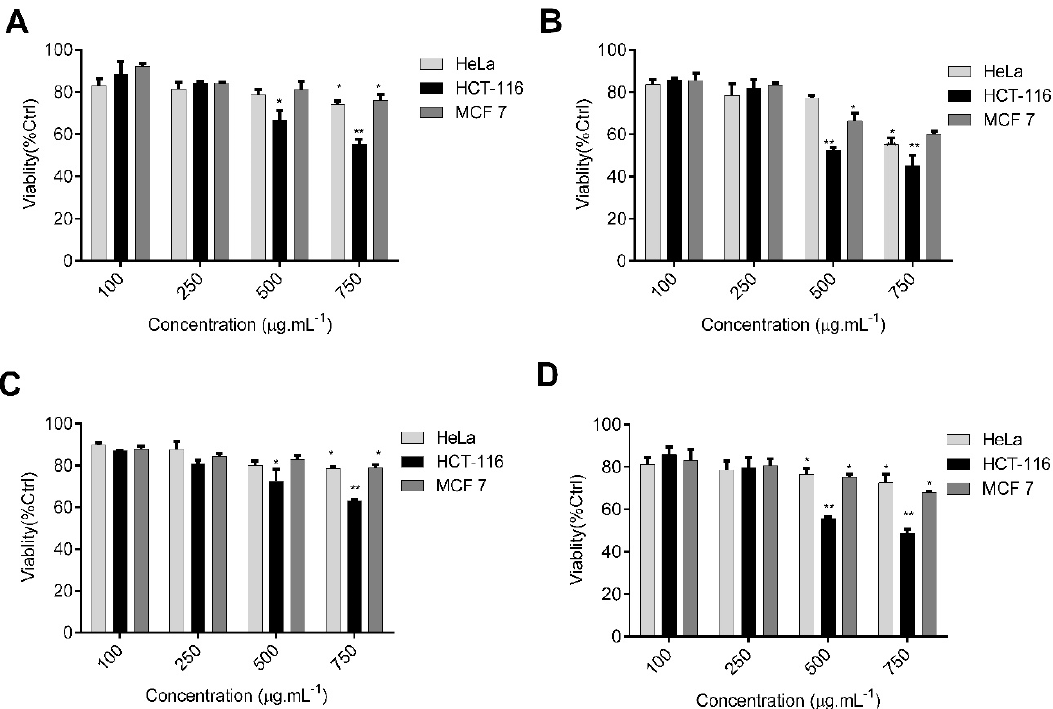
Figure 6. Cytotoxic effects of fucoidan and alginate on the viability of various cancer cells (HCT-116, MCF 7, and HeLa). Different concentrations of fucoidan on tumor cells were tested at 24 h ( A ) and 48 h ( B ). Cytotoxic potentials of alginate against these cancer cell lines were also examined at 24 h ( C ) and 48 h ( D ) (mean ± SD; n = 3). Significant differences are indicated as * p < 0.05 and ** p < 0.01 with respect to control.